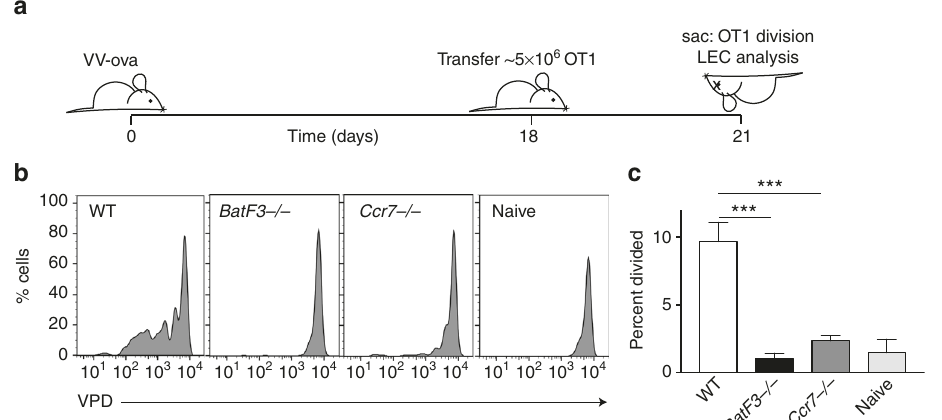
Fig. 5 Antigen exchange following vaccinia infection requires both BatF3 and Ccr7. a Schematic of experimental design. b WT, BatF3 − / − , and Ccr7 − / − mice were infected with vaccinia-ova and 2 weeks later violet proliferation dye (VPD)-labeled OT1 T cells were transferred. OT1 division was evaluated (Supplementary Fig. 3). c Quanti fi cation of the percent divided in the groups shown in b , where mice of each genotype were pooled from three independent experiments of three mice each. Statistical analysis was done using an unpaired t -test where the p -value between wild type and BatF3 − / − is < 0.0001 or wild type and CCR7 − / − is < 0.0001. Error bars are mean ± standard error of the mean